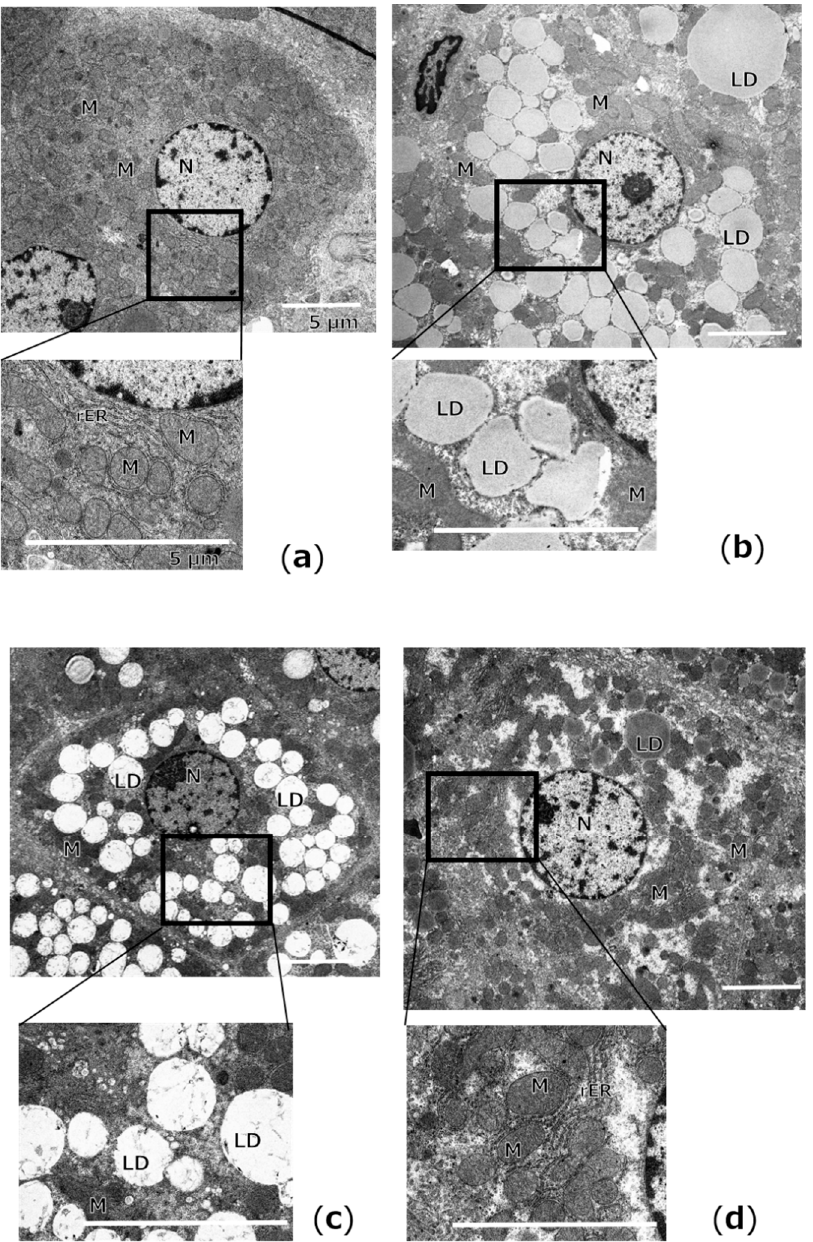
Figure 2. Representative images of electron micrographs of hepatocytes from the lean control (L; a ), obese (Ob; b ), dietary restriction (DR; c ), and dietary restriction plus exercise (DR + Ex; d ) groups. Lipid droplets (LD); mitochondria (M); nuclei (N); rough endoplasmic reticulum (rER). Scale bars = 5 μ m.